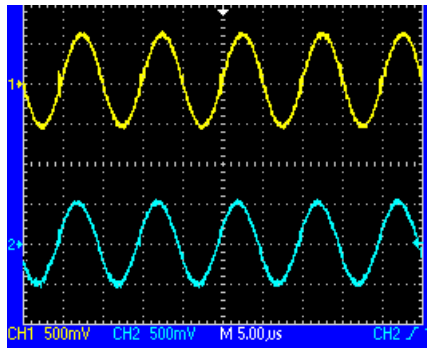
Figure 5. Resonant outputs of the coils with the same